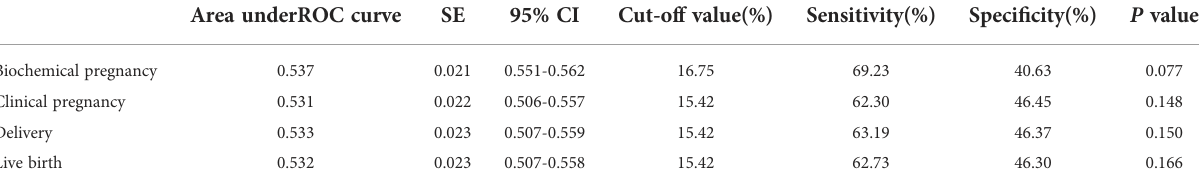
TABLE 4 ROC curve analysis of the sperm DFI for IUI pregnancy.